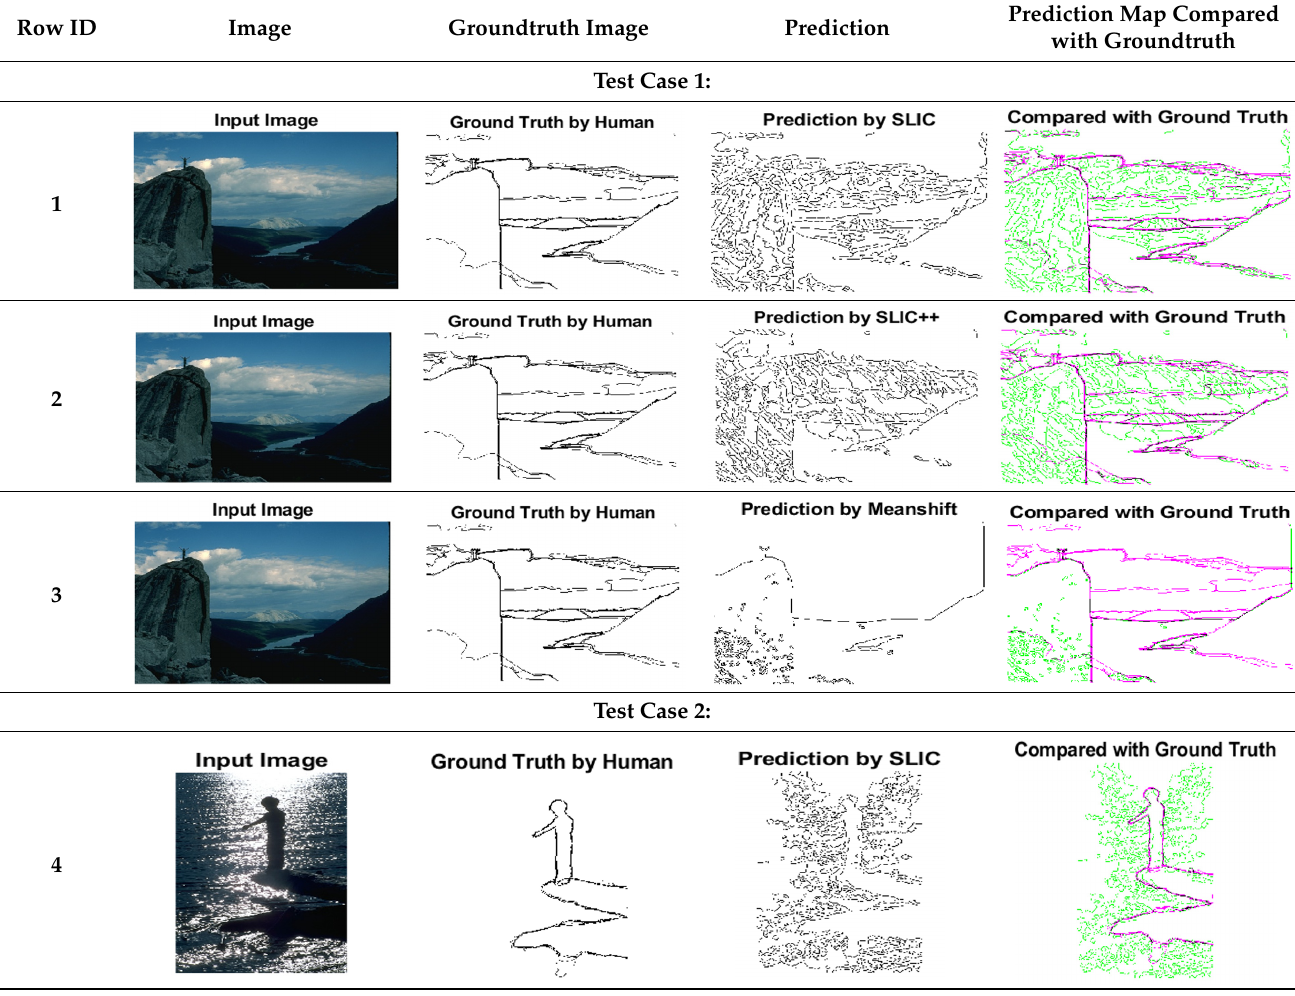
Table 5. Semi-dark perceptual results conforming boundary retrieval.